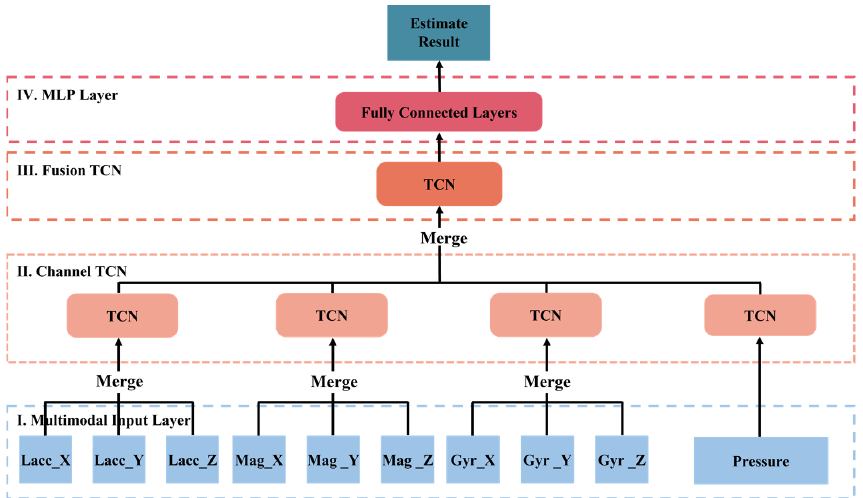
Figure 1. The schema of the overall overview of our proposed T2Trans model. Preprocessed sensor data are fed into the model from the multimodal input layer, which are fed into ten channel TCN layers, respectively. The fusion TCN layer model structure is similar to that of the channel TCN layer. In the MLP layer, feature representations from the fusion TCN layer are implicitly learned.